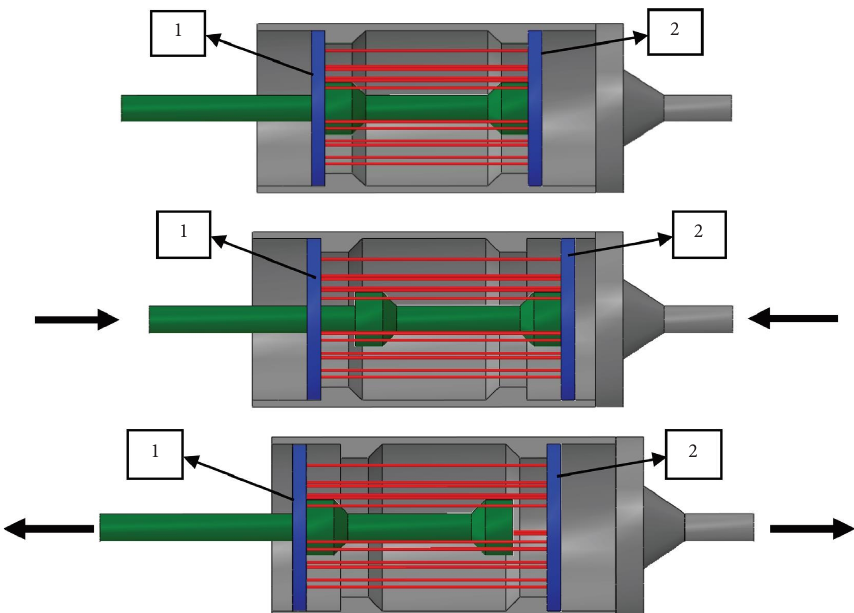
Figure 11: Te performance of the suggested damper under tension and compression.